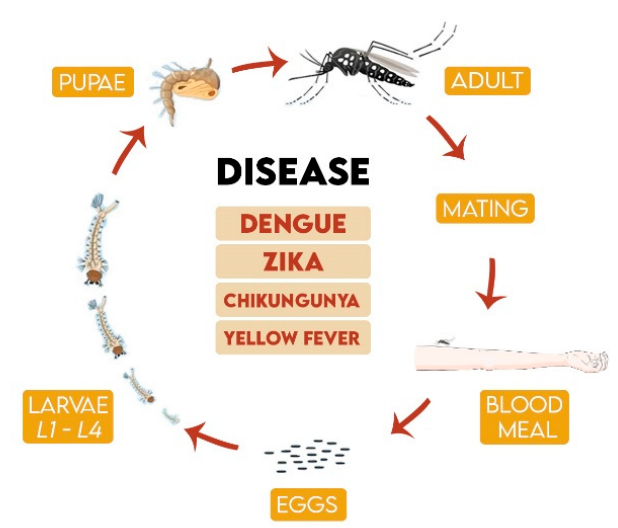
Figure 1. Aedes aegypti life cycle and the main arboviruses transmited by the female mosquito.